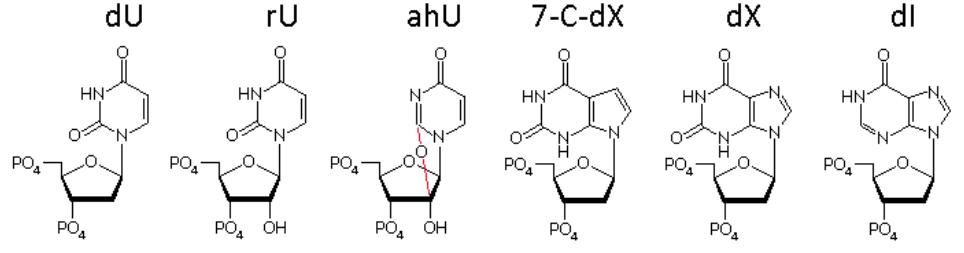
Figure 1. The structures of the main deaminated bases.